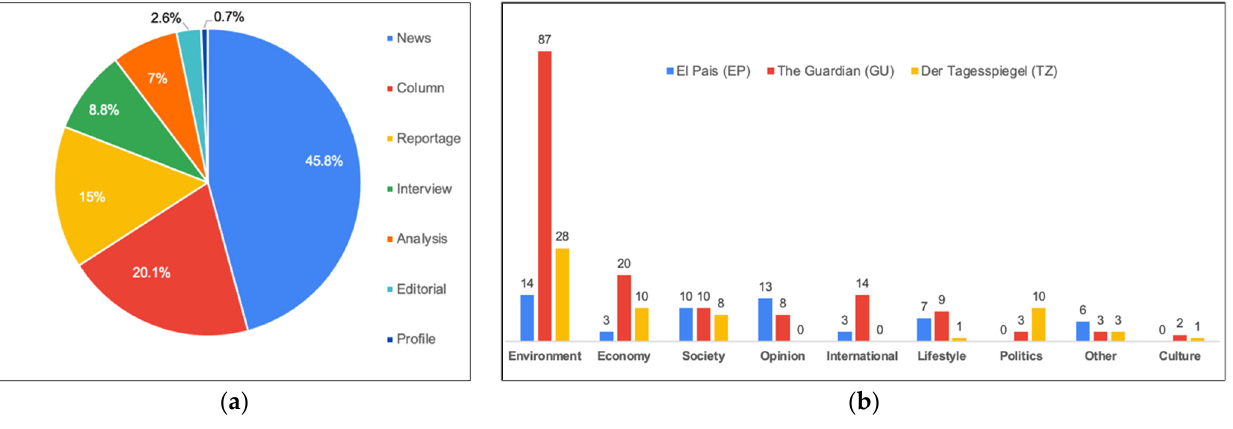
Figure 3. ( a ) Percentage of journalistic genres referred to the items included in the general sample; ( b ) percentage of items per genre published by media outlet (%). ( b ) percentage of items per genre published by media outlet (%).